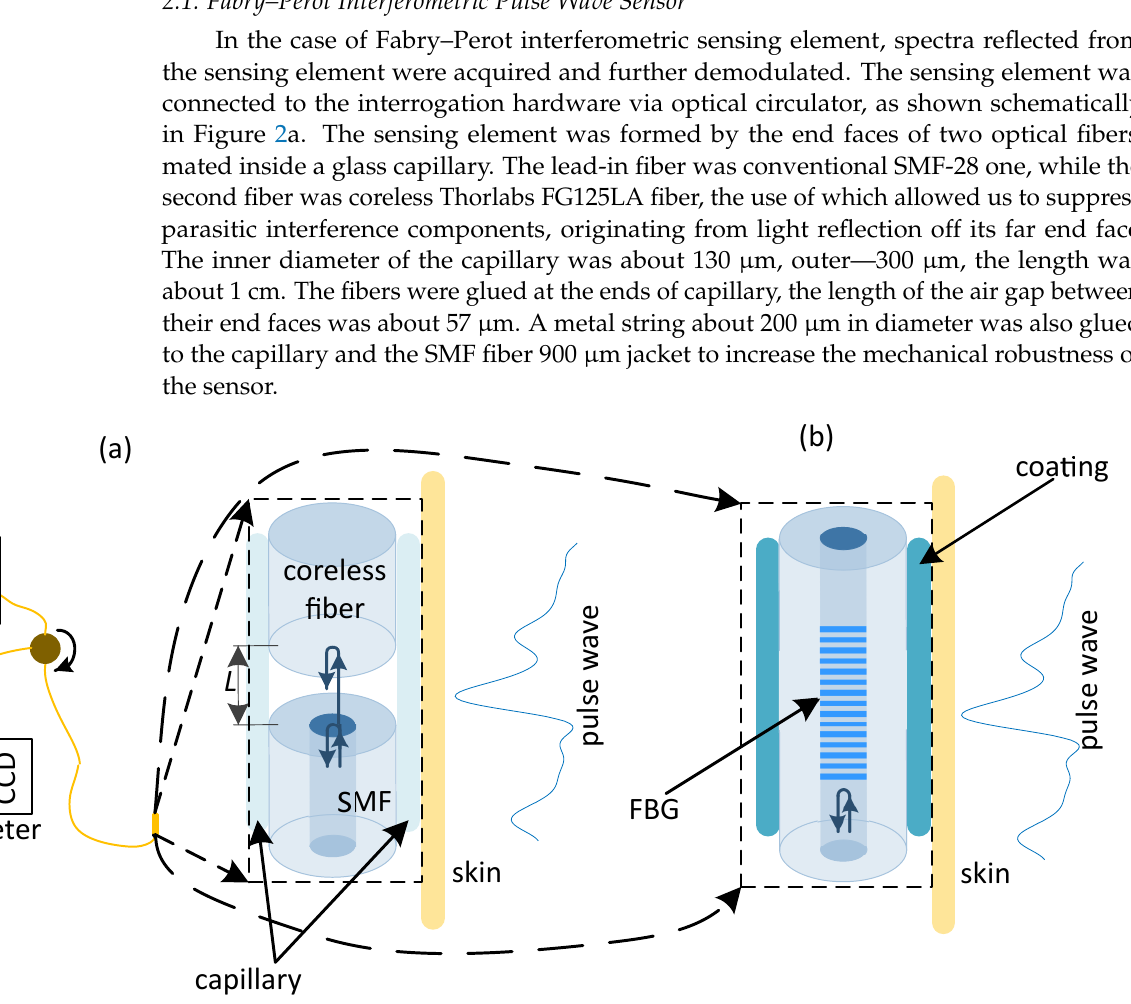
Figure 2. Schematic illustration of sensing setups for FPI ( a ) and FBG ( b ) pulse wave